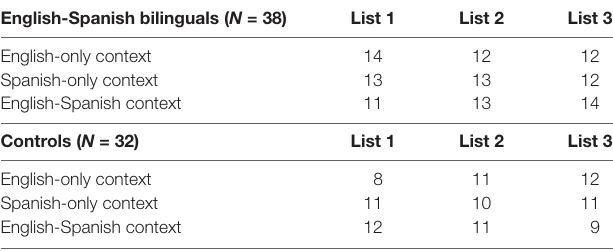
TABLE 2 | Order of conditions by